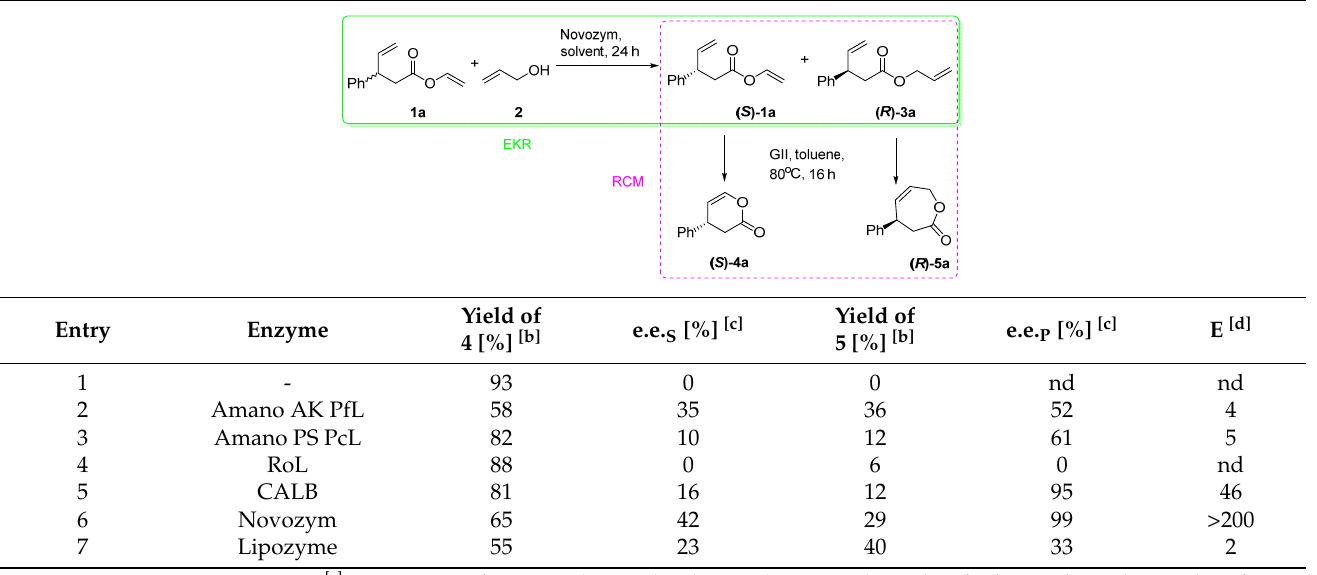
Table 1. The impact of enzyme on EKR of 1a [a] .